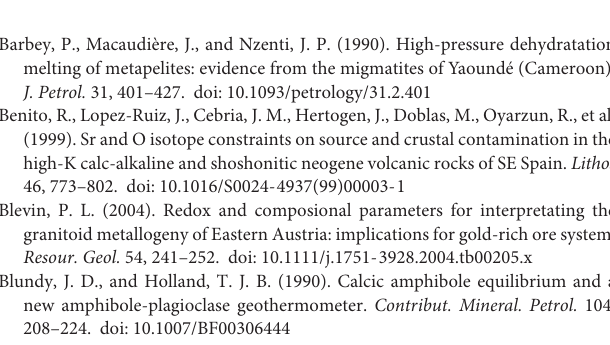
TABLE S4 | Selected microprobe analyses of amphibole from amphibole granite. TABLE S5 | Selected microprobe analyses of